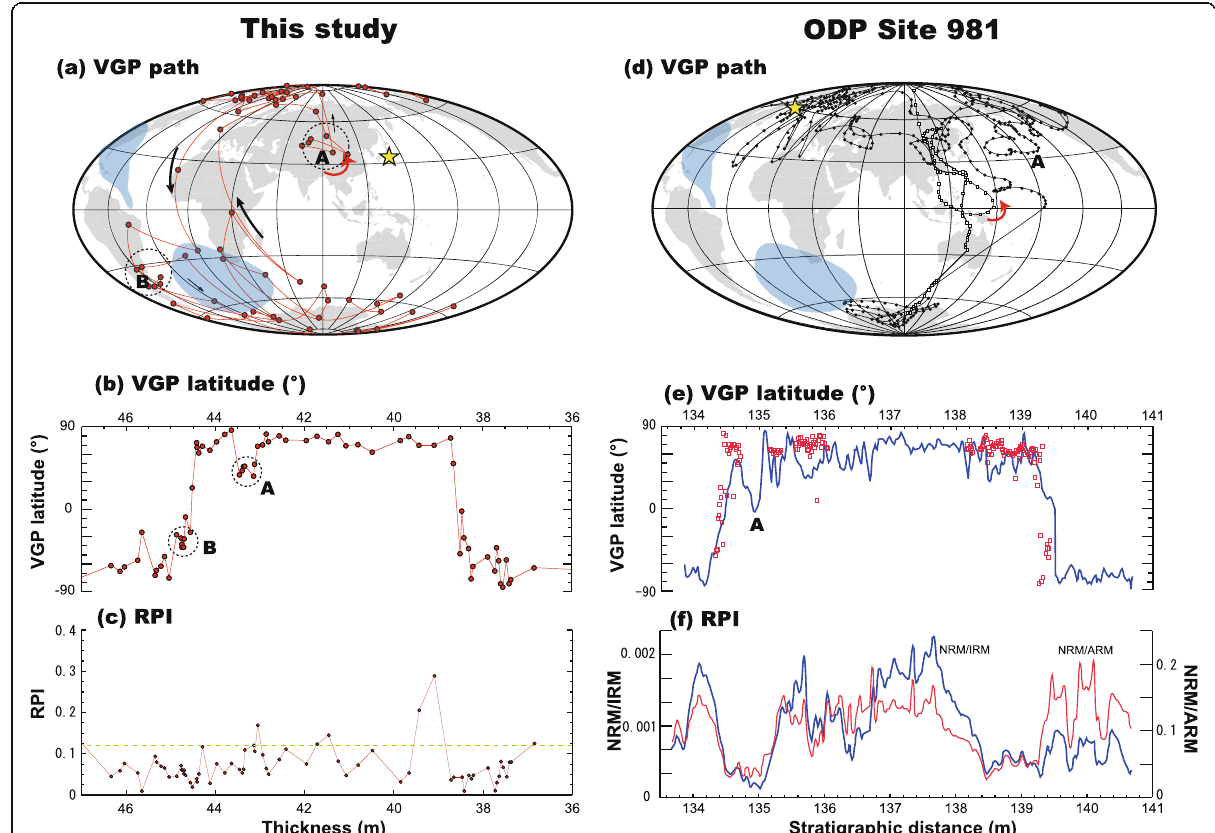
Fig. 8 VGP paths and horizontal plots of the VGP latitude and RPI covering the Réunion subchron that correlates with a North Atlantic record. a – c Show the results of this study. d – f Show the results from ODP Site 981 (Channell et al. 2003). The letter “ A ” and “ B ” in ( a ) and ( b ), and “ A ” in ( d ) and ( e ) indicate parts of the characteristic VGP clusters identified on ( a ) and ( d ), respectively. The blue shaded areas in ( a ) and ( d) , indicate that the vertical component of the NAD field at the Earth ’ s surface is less than − 15 μ T (Constable 2007). The yellow stars indicate the sample/core sites. The green dashed line in ( c ) indicates the average RPI value for the entire interval of this